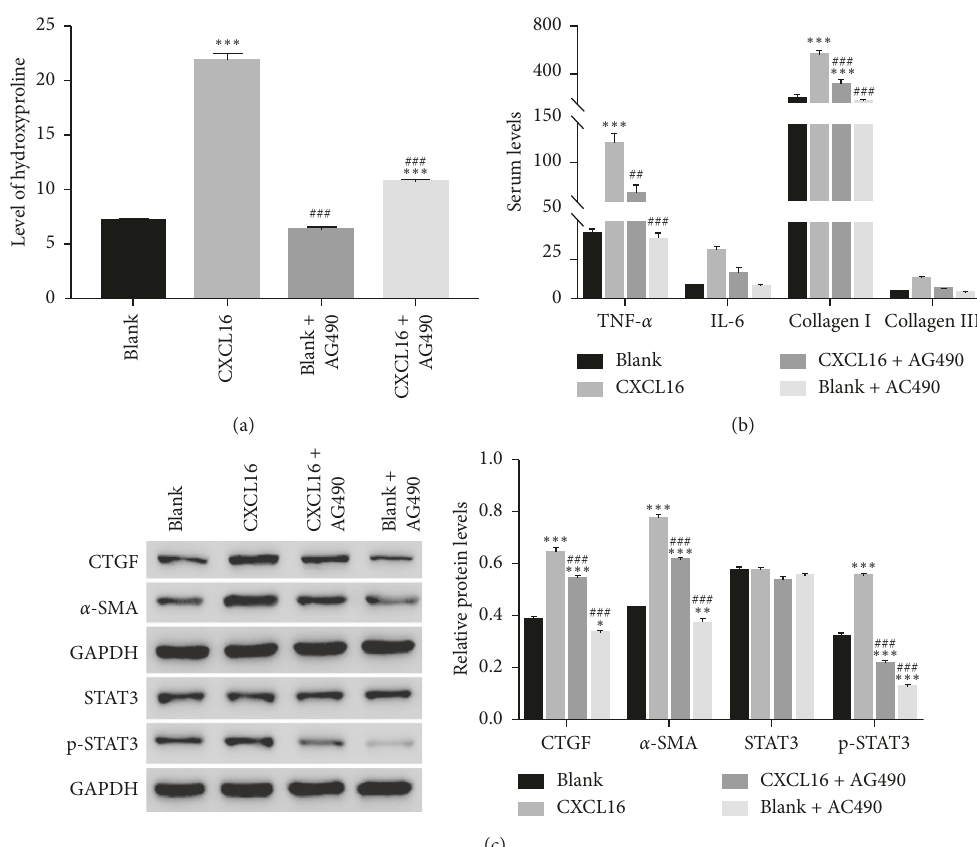
Figure 5: The effect of CXCL16 was inhibited by the STAT3 inhibitor AG490 on mouse LF cells. (a) The inhibitor AG490 suppressed the production of HYP in CXCL16 treated cells ( ∗∗∗ p < 0 . 001 vs Blank; ### p < 0 . 001 vs CXCL16). (b) The serum level of TNF- α , IL-6, collagen I, and collagen III detected in different cells as indicated. (c) The protein level of CTGF, α -SMA, STAT3, and p-STAT3 was inhibited by